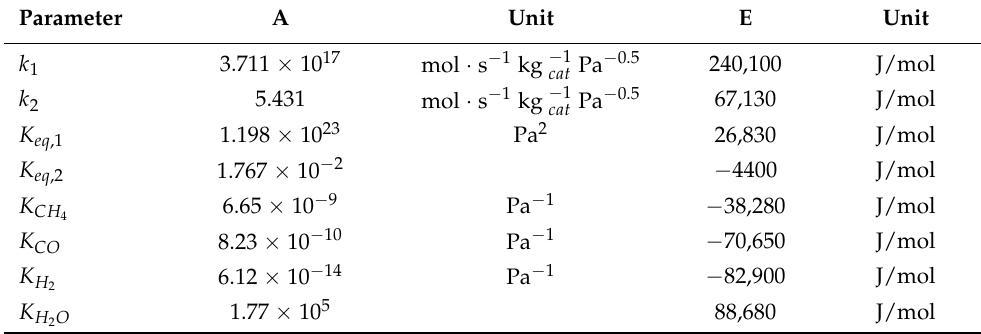
Table 1. Kinetic parameters for the calculation of the reaction